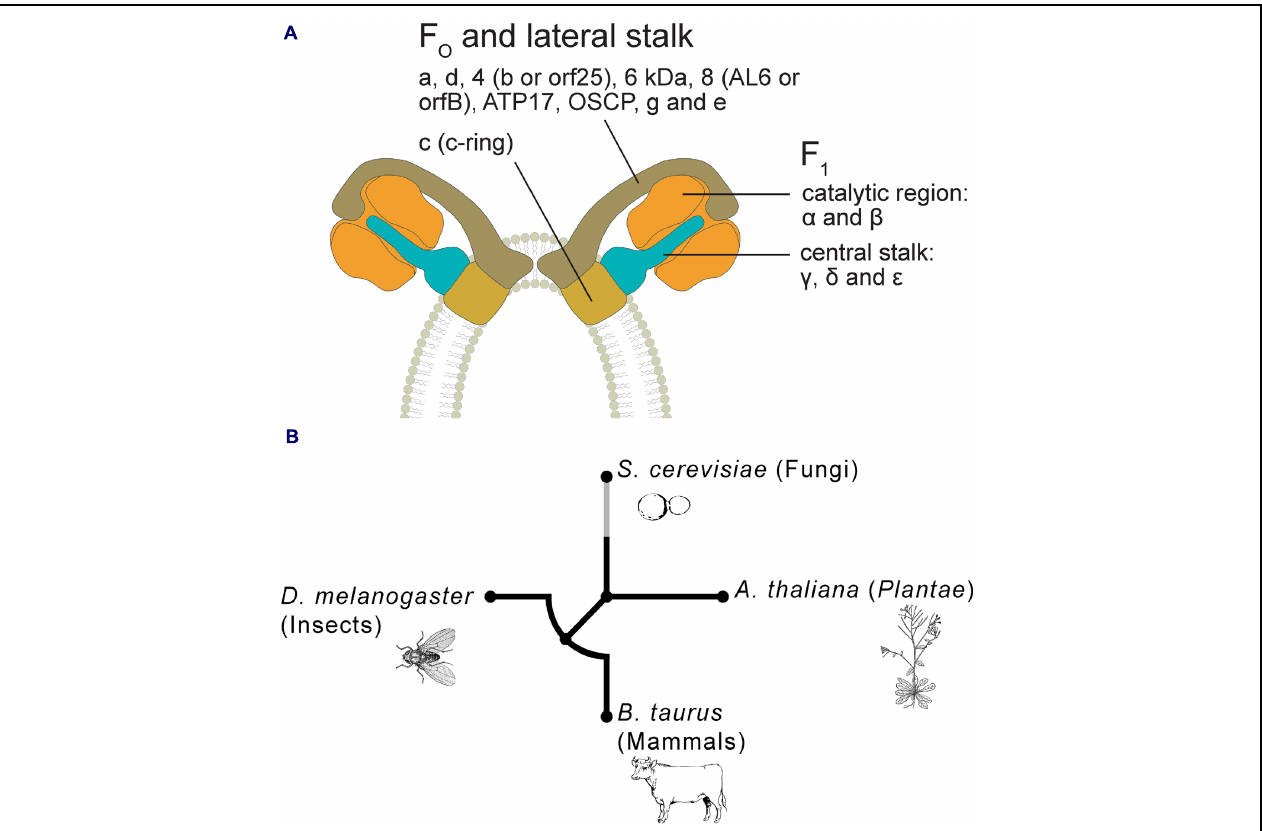
FIGURE 1 | (A) Hypothetical model of PTP in plants, based on F-ATPase dimer formation, as proposed by Bernardi (2013b), Bonora et al. (2013), and Alavian et al. (2014). Plant F-ATPase subunits are organized on the basis of their putative correspondence to the mammalian ones. (B) Circular phylogenetic tree of peptide sequences of homologous subunit g of mitochondrial ATP synthase in four representative taxa (i.e., Bos taurus , Drosophila melanogaster , Saccharomyces cerevisiae , and Arabidopsis thaliana ). Alignments of multiple amino acid sequences were performed using MUSCLE software (Edgar, 2004). Phylogenetic trees were obtained using phyML version 3.0 with the maximum-likelihood (ML) method (Guindon et al., 2010). The NCBI Reference Sequence accession codes for the g subunit are: B. taurus = NP_001019721; D. melanogaster = NP_609142; S. cerevisiae = NP_015345; A. thaliana = NP_179558. Where more isoforms were found in NCBI databases, we randomly selected only one of these